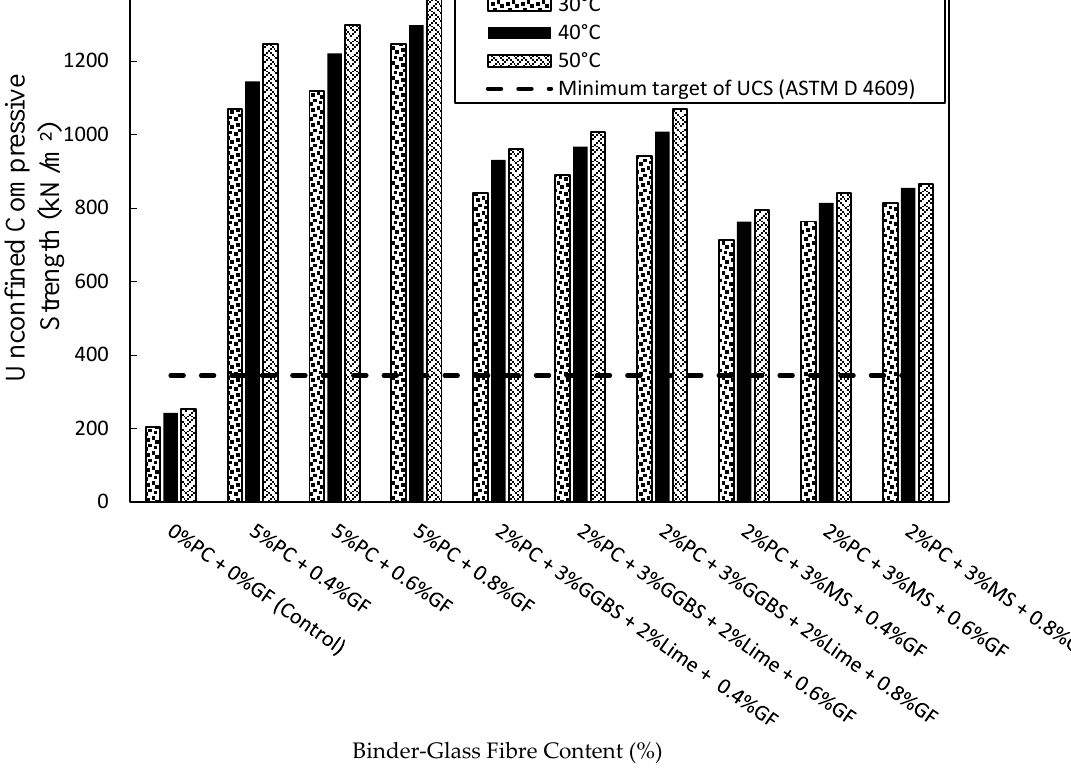
Figure 8. UCS of glass fibre-reinforced clay-binder mixtures tested after 24 h cooling period.